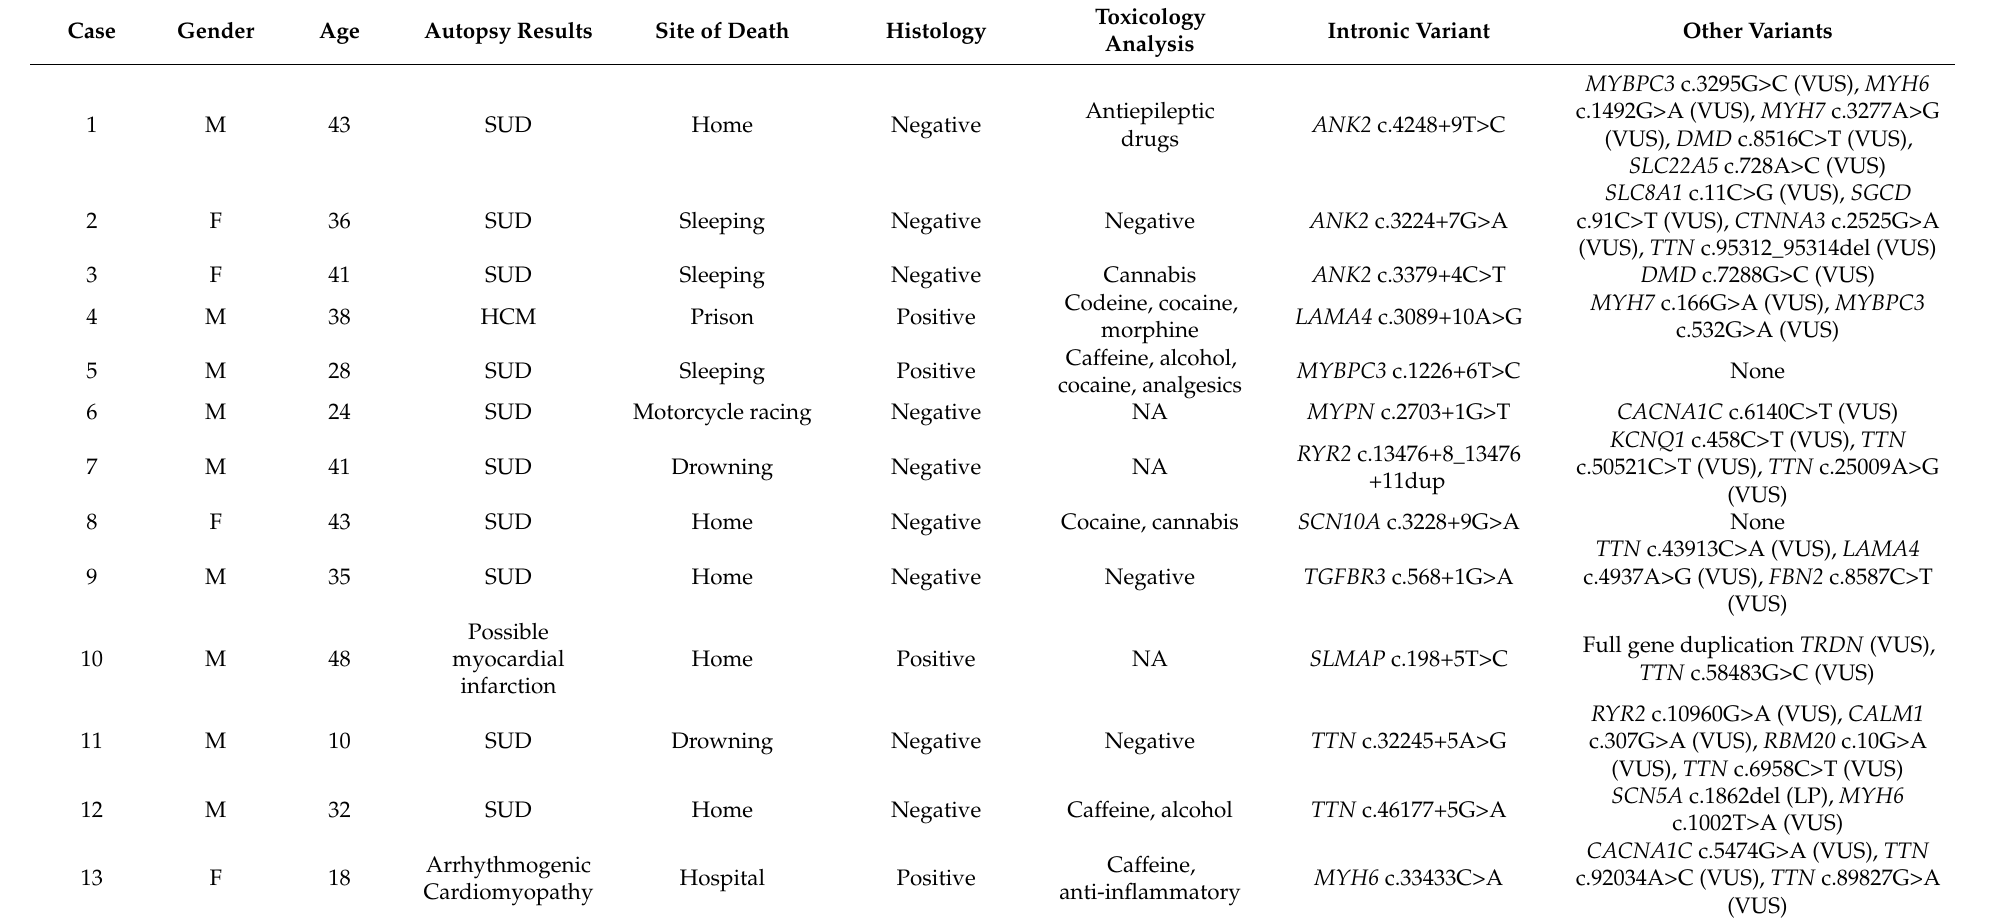
Table 1. Autopsy details for SCD cases. F = female, M = male, SUD = sudden unexplained death, HCM = hypertrophic cardiomyopathy. Toxicology analysis showed detectable levels of